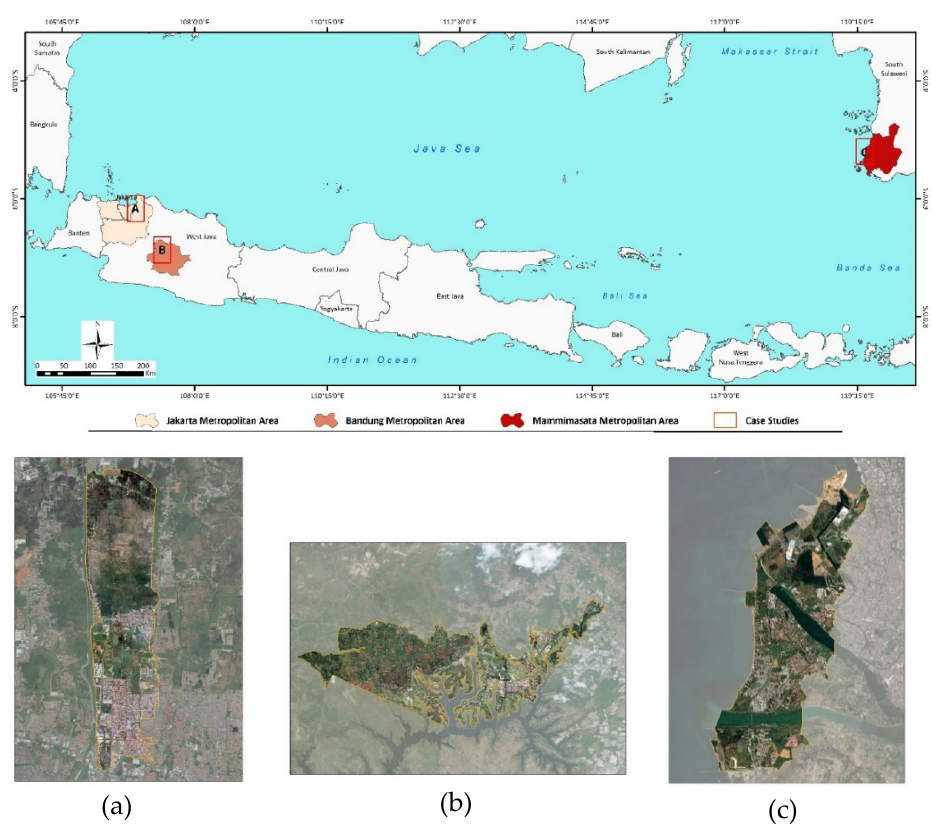
Figure 3. Locations of three case study areas: ( a ) Kota Harapan Indah (KHI), ( b ) Kota Baru Parahyangan (KBP), and ( c ) Metro Tanjung Bunga (MTB). Source: Pleiades Satellite Imagery, 2017.